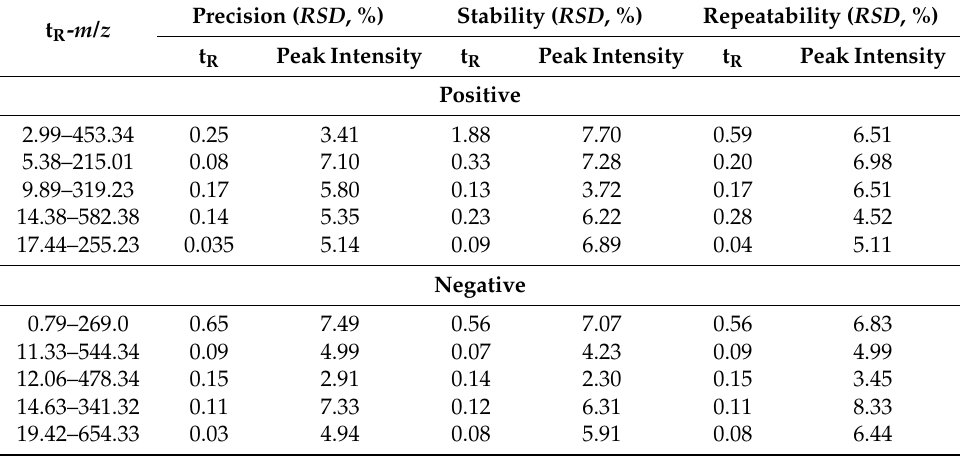
Table 1. The analytical performance of the UPLC-MS method ( n =